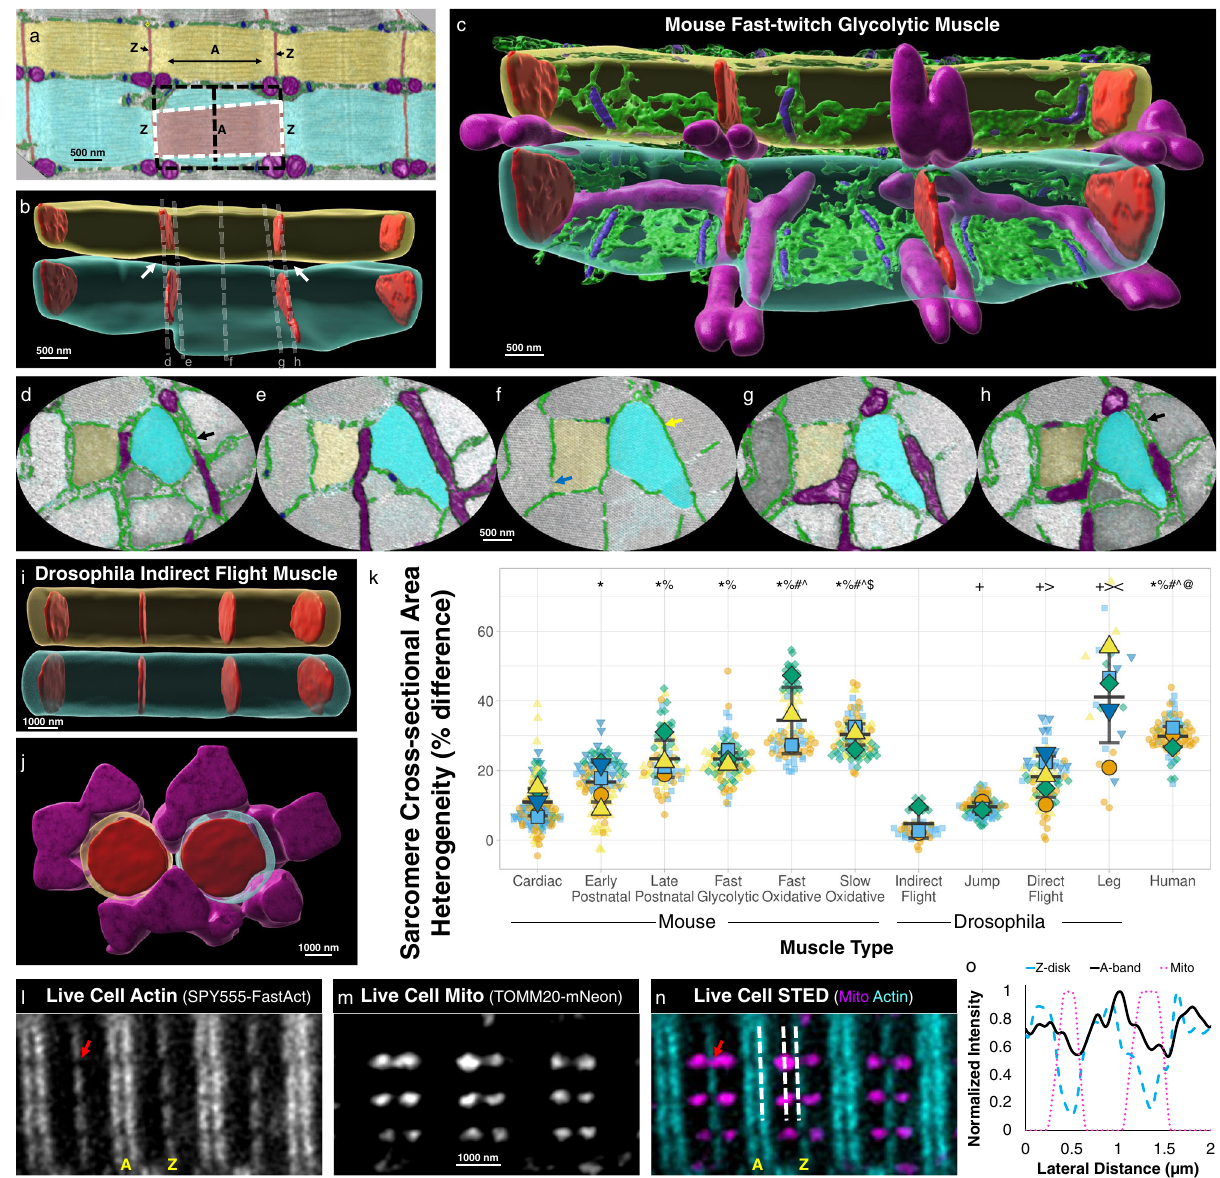
digitorum brevis (FDB) muscles labeled with fl uorophores for mito- chondria (genetically encoded TOMM20-mNeon 45 ) and F-actin (SPY555-FastAct) (Fig. 1l – n). SPY555-FastAct dye is based on the F-actin linker jasplakinolide 46 , and appears to label the actin fi